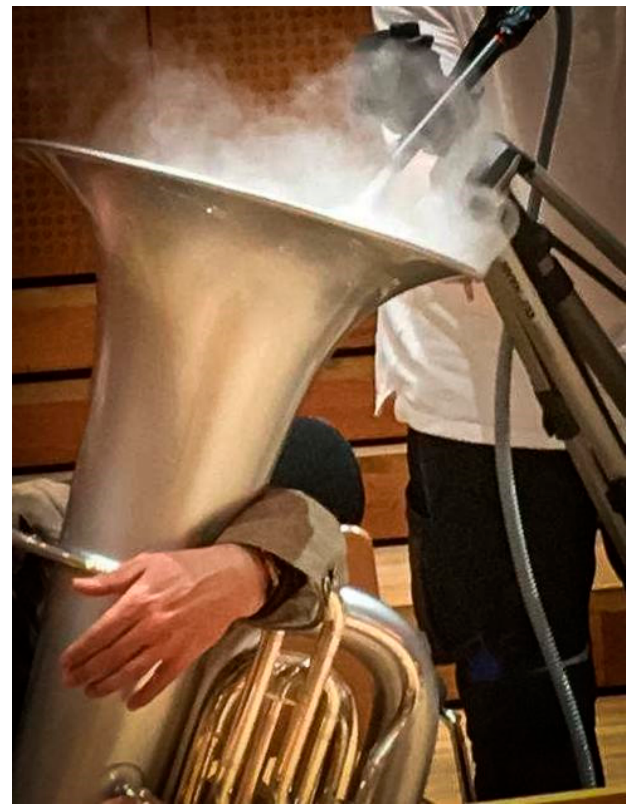
Figure A8. Artificial fog at the bell of the tuba.